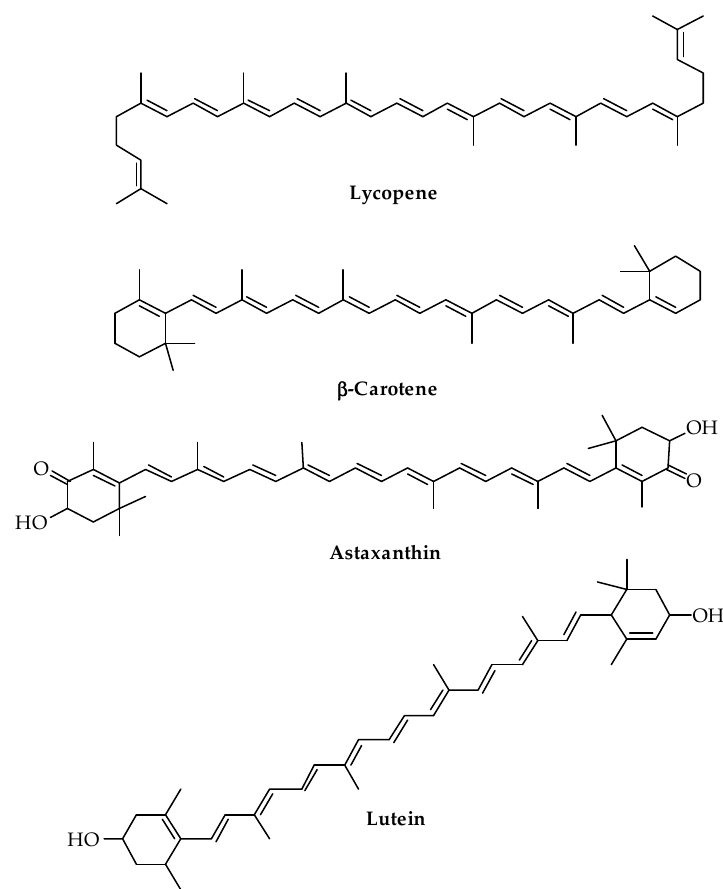
Figure 10. Chemical structure of the most important carotenoids.